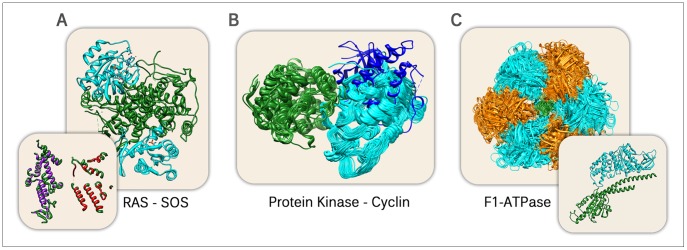
Three typical interactions exhibiting surprising variety.(A) Protein ‘ras’ binds to ‘son of sevenless’ (1NVV): alternative binding for sequence-identical pairs of proteins and without a multimeric context; the lower left panel shows the residues of the two interfaces in purple and red. (B) Natural dimeric interactions between proteins from the protein kinase and cyclin families (interface copy number 1; e.g. 1OI9). Cyclin chains (green) have been structurally aligned and superimposed. Protein kinases (cyan and blue) were subject to the same geometric translations. The blue chain has a recently discovered outlier interface (see text). (C) Superimposition of entire sequence-identical F1-ATPase complexes. Complexes were aligned and superimposed with the gamma chains (green). Alpha (orange) and beta (cyan) subunits were subject to the same geometric translations. In the main panel, we look at the complexes from the top. The inlet displays an interaction between a beta and a gamma subunit from the side.